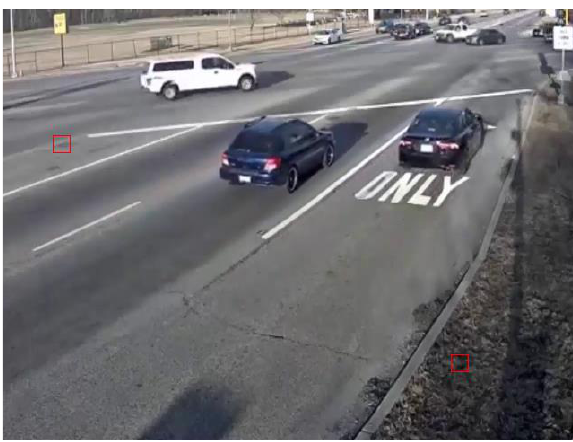
Fig. 5. The same as Figure 4 but for another frame.